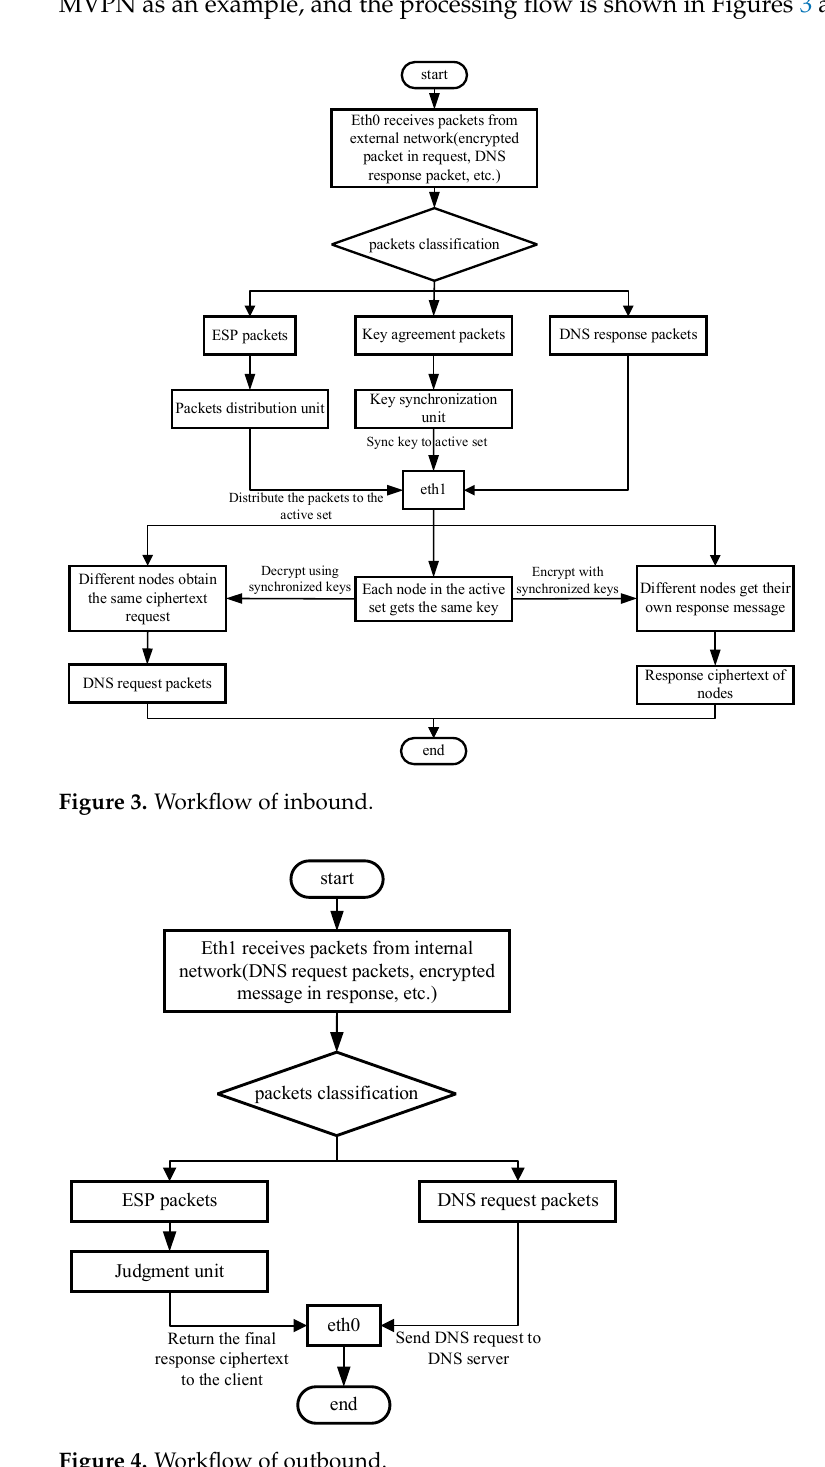
Figure 2. MVPN functional framework. ( The blue part indicates that the development is based on DPDK, and the red part indicates that the development is based on Redis.)